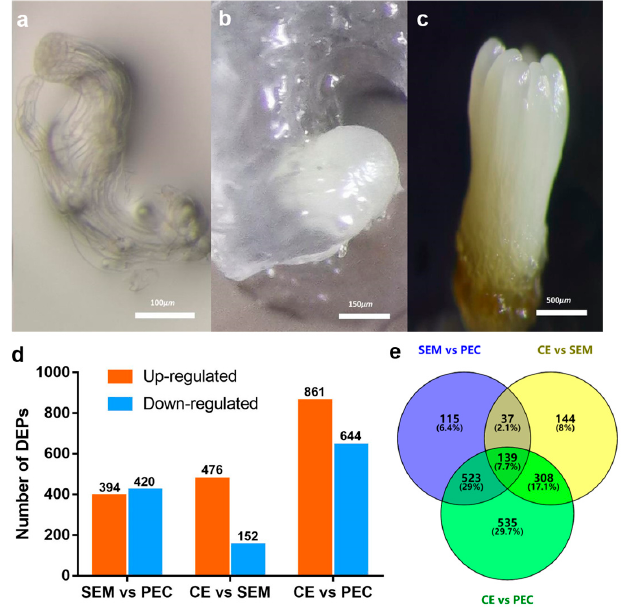
Figure 1. Images of three stages of SE. ( a ) primary embryogenic callus; ( b ) single embryo; ( c ) coty ‐ ledon embryo. DEPs in different comparison groups in SE. ( d ) Number of DEPs with up ‐ regulated and down ‐ regulated expression; ( e ) Venn diagram showing the distribution of DEPs shared and unique to the three comparison groups: SEM vs. PEC (blue circle), CE vs. SEM (yellow circle), and CE vs. PEC (green circle).